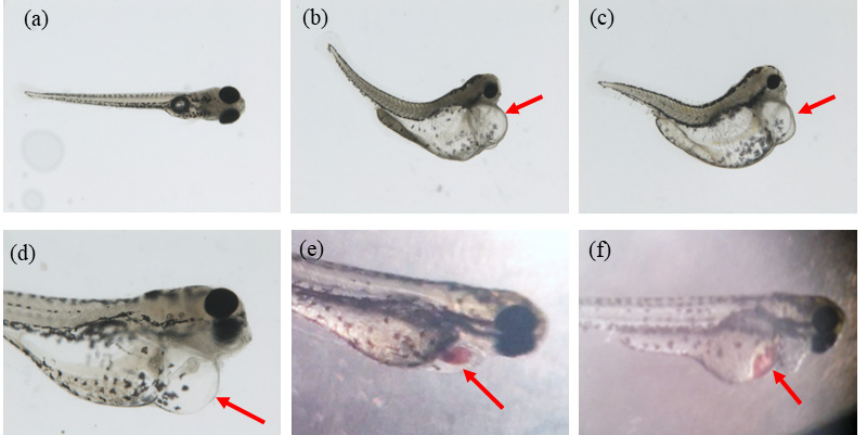
Figure 2. The various malformation after being ethanol-treated. ( a ) normal; ( b , c ) pericardial edema, yolk sac deformity and spinal curvature; ( d ) pericardial edema; ( e ) heart bleeding; ( f ) liver bleeding.